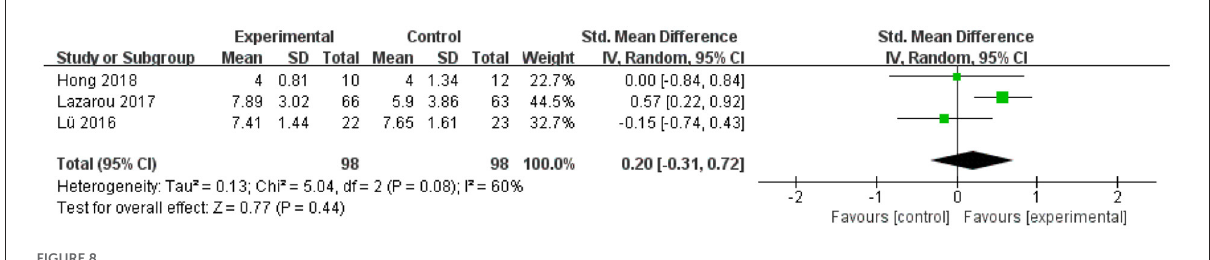
FIGURE8 The influence of exercise interventions on